Question: State the chart type depicted above.
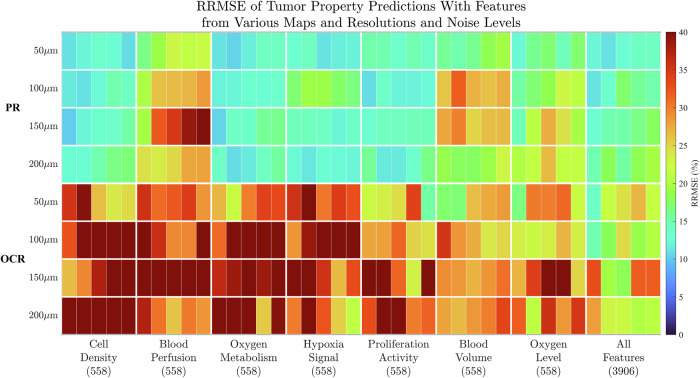
Answer: heatmap